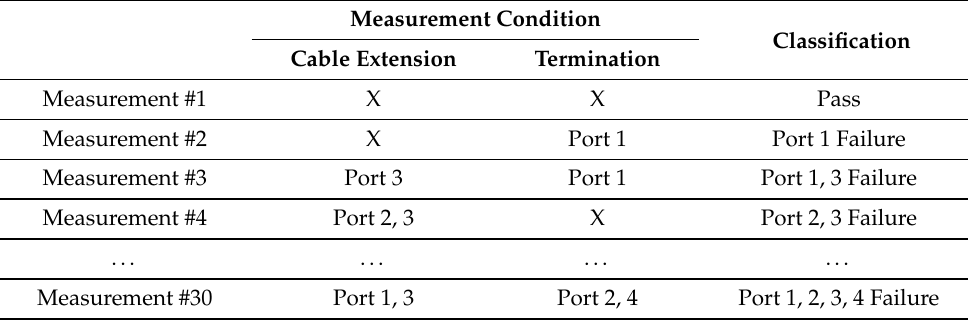
Table 10. Classification criteria for measurement conditions.